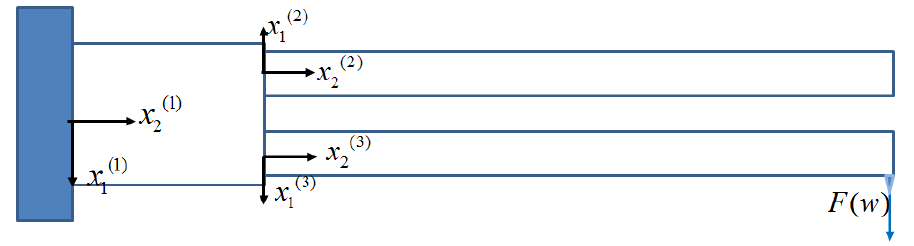
Figure 8. Three sets of coordinates of the cantilever quartz tuning fork (QTF).